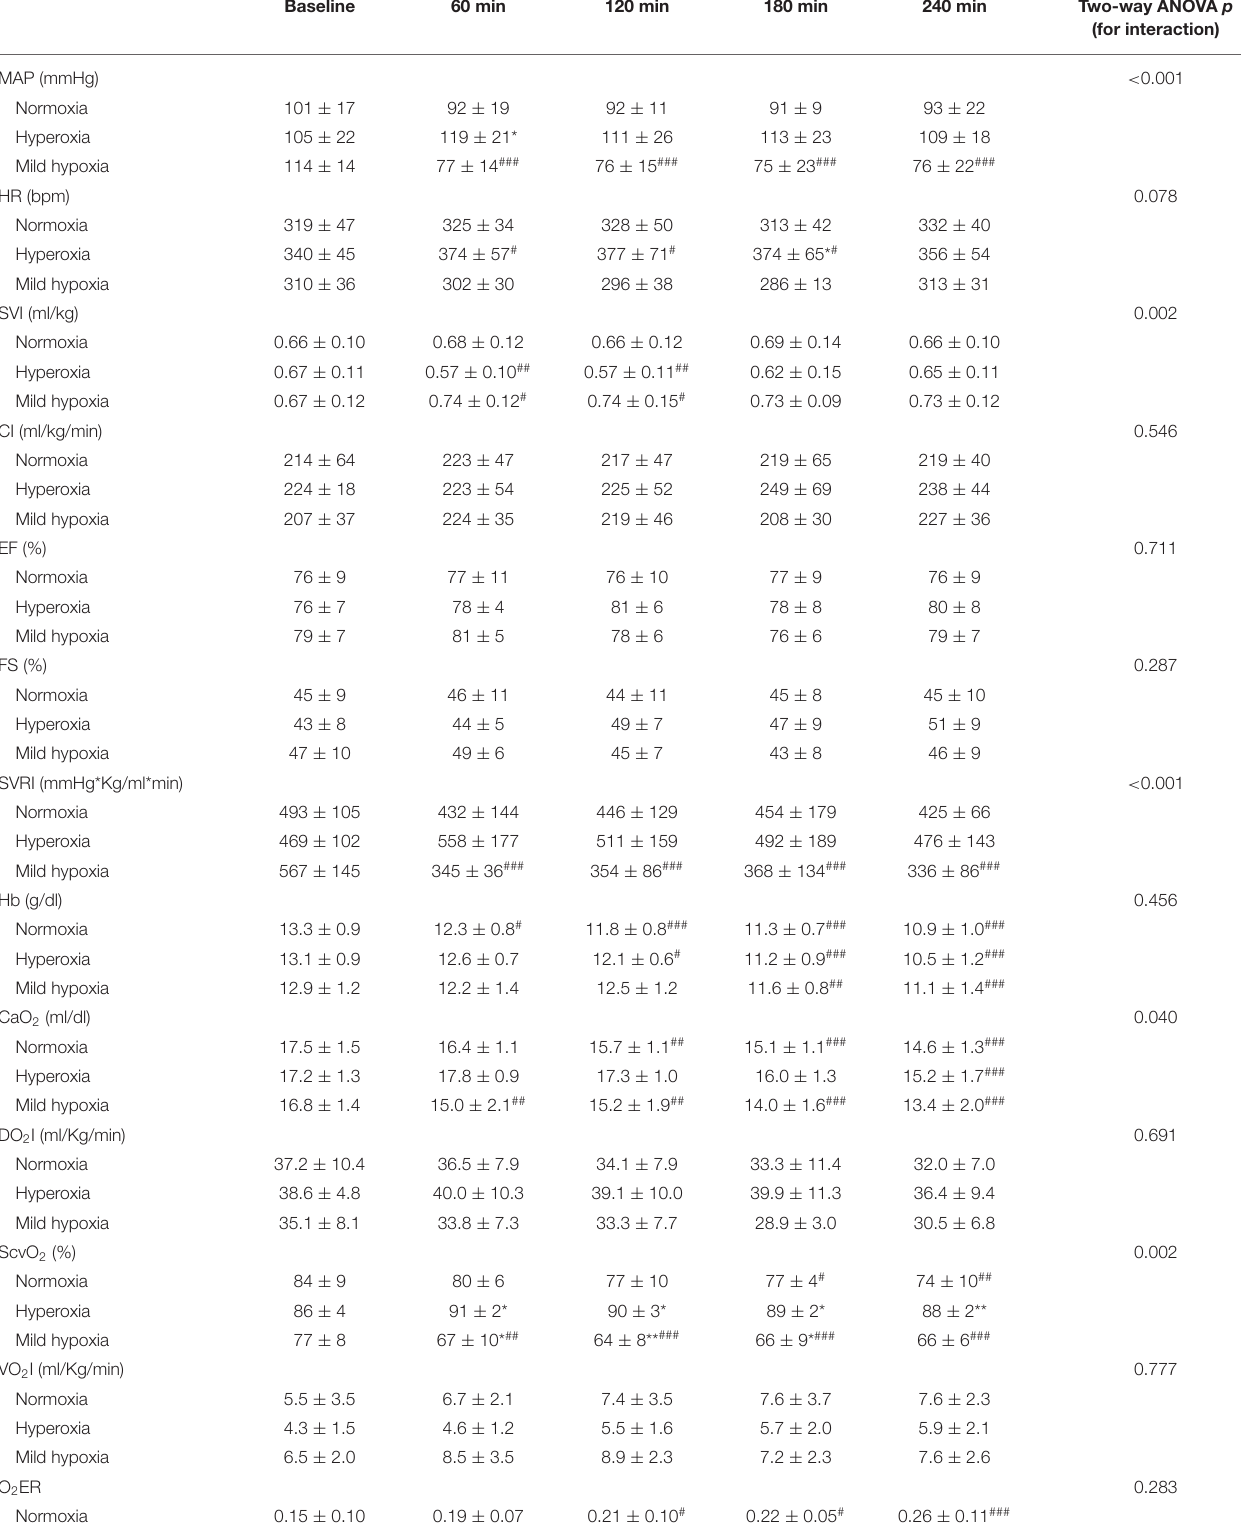
(for interaction)